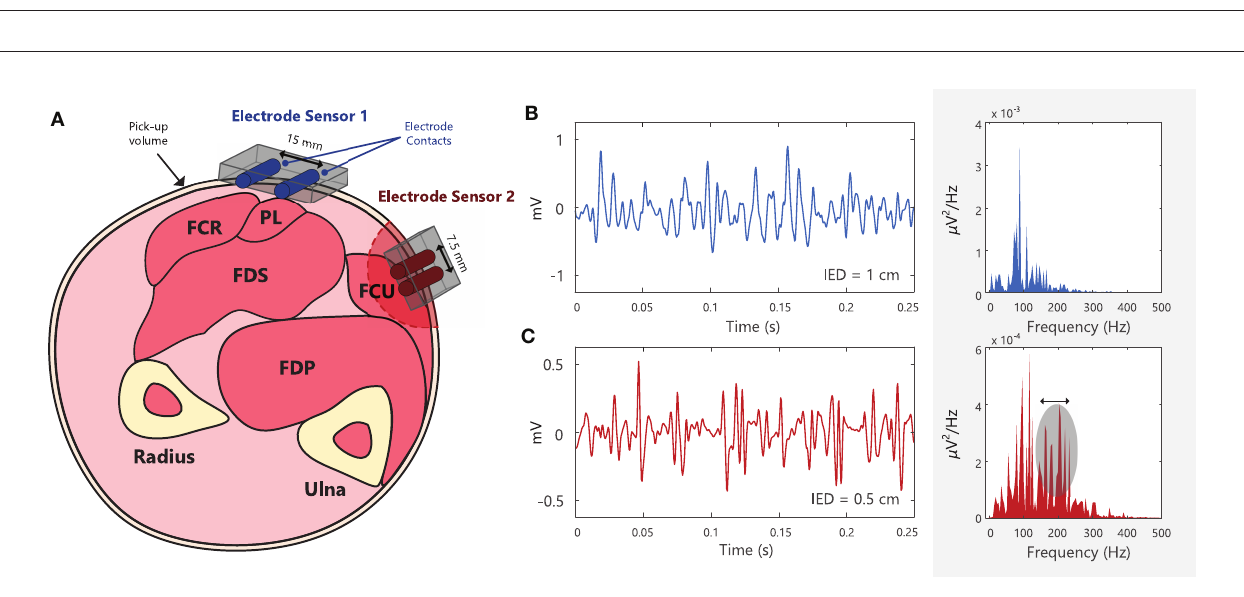
FIGURE 6 | (A) Schematic of the cross-section of the forearm, with the approximate locations of different muscles: flexor carpi radialis (FCR), palmaris longus (PL), flexor digitorum superficialis (FDS), flexor digitorum profundus (FDS), and flexor carpi ulnaris (FCU) ( 62). Note that electrode contacts should be placed approximately parallel to the muscle fiber direction. Electrode sensor 1 is placed over PL, but it will detect muscle activity (or crosstalk) from the adjacent/deep muscles, FCR and FDS. Electrode sensor 2 has a smaller inter-electrode distance (IED) than Electrode sensor 1 and will thus have a smaller pick-up volume. (B,C) Two EMG signals recorded using different electrodes with different IEDs, shown in both the time and frequency domains. EMG signals recorded using smaller IEDs can capture more high frequency components when compared with larger IEDs. Note that this diagram is for illustrative purposes and that the power spectra of the EMG signals cannot be directly compared between (B) and (C) , as they were recorded in different muscles, under different conditions, using different electrodes. See Example (xi) in Tutorial